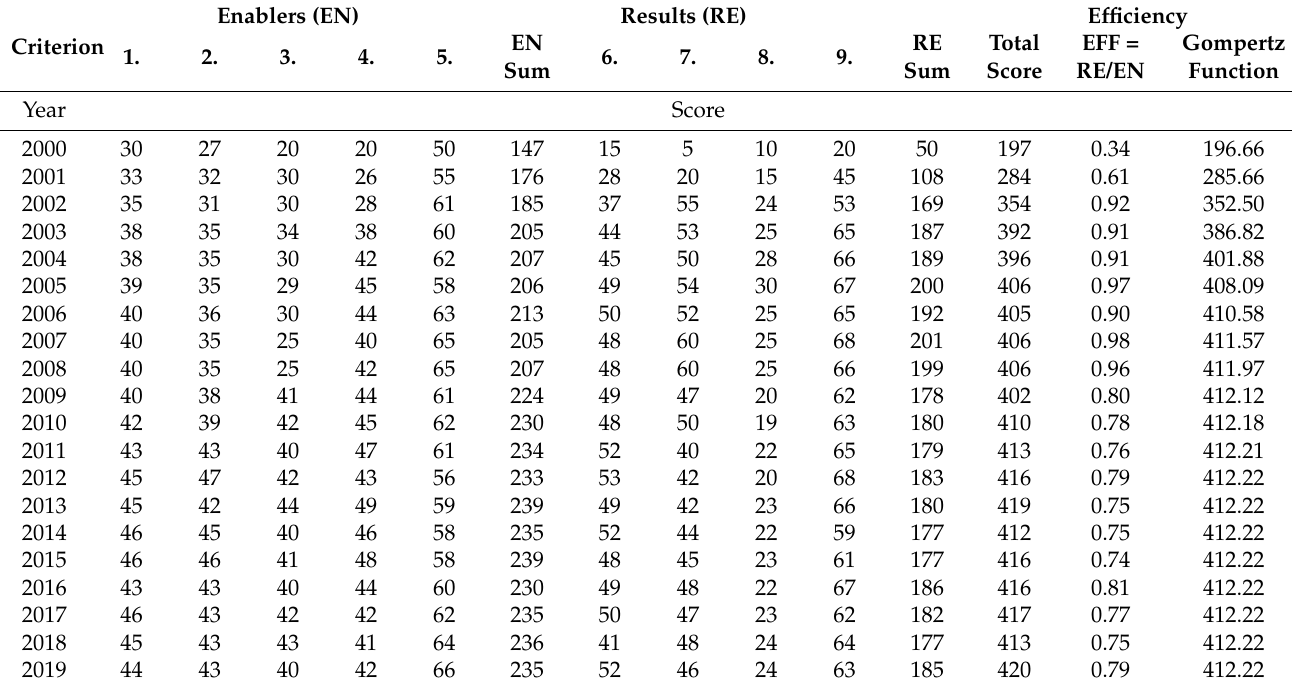
Table A4. Measured scores, calculated Efficiency, and Gompertz function